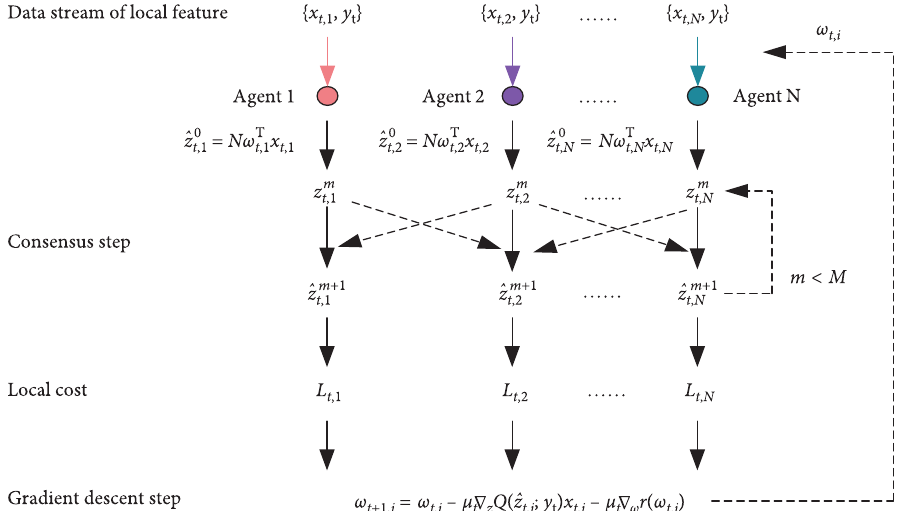
Figure 2: The framework of the proposed